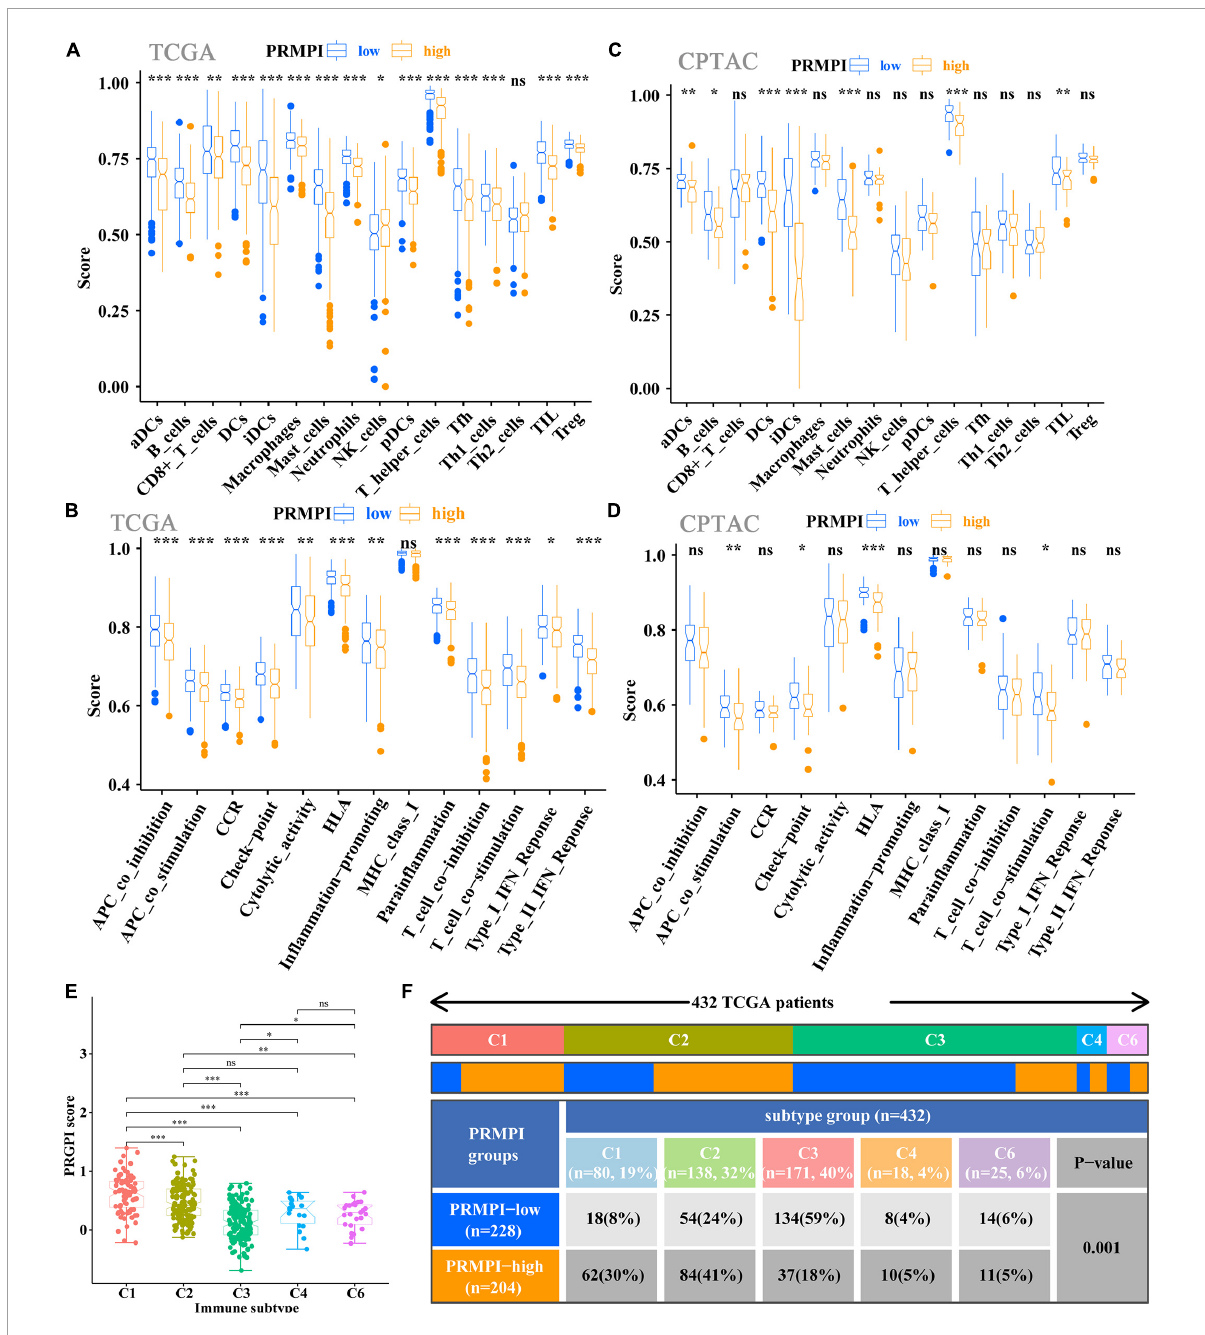
FIGURE6 Tumor-infiltrating immune cells and immune-related pathways between the PRMPI subgroups. (A,B) Enrichment scores of 16 types of tumor-infiltrating immune cells and 13 immune-related pathways between the PRMPI subgroups in TCGA cohort. (C,D) Enrichment scores of 16 types of tumor-infiltrating immune cells and 13 immune-related pathways between the PRMPI subgroups in the CPTAC cohort. (E) Comparison of the PRMPI score in five immunophenotypes (C1, C2, C3, C4, C6). (F) Heat map and table showing the distribution of five immunophenotypes between the PRMPI subgroups. The distributions of the immunophenotype in the PRMPI subgroups were compared by using the chi-square test. * p -value < 0.05; ** p -value < 0.01; *** p -value < 0.001. PRMPI, pyroptosis-related mRNA prognostic index. ns, no significance.